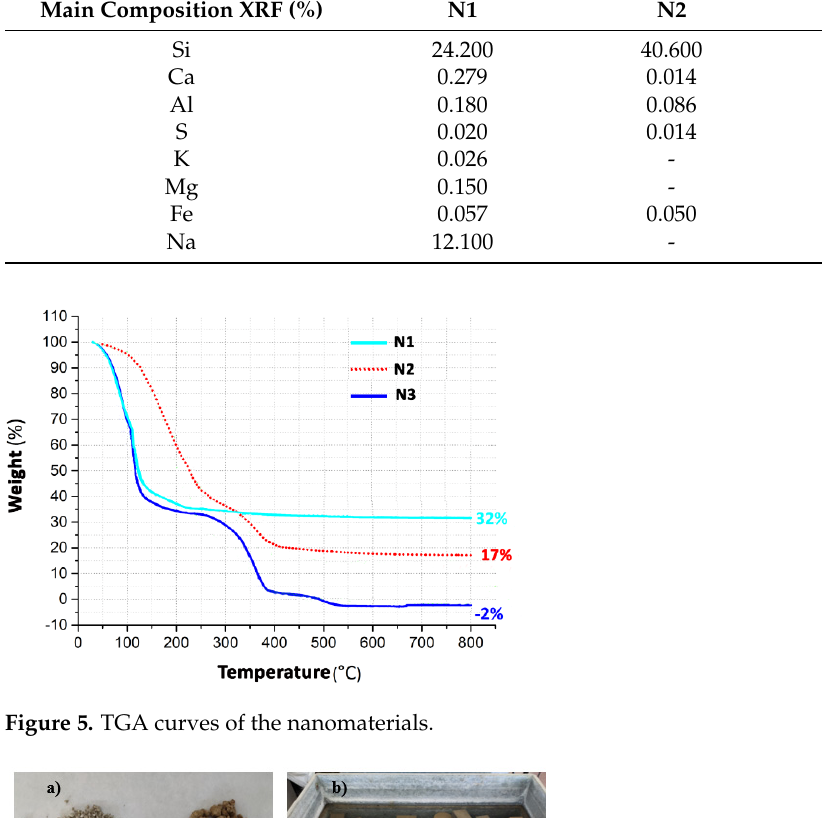
Table 3. Main composition XRF (%) of the nanomaterials.